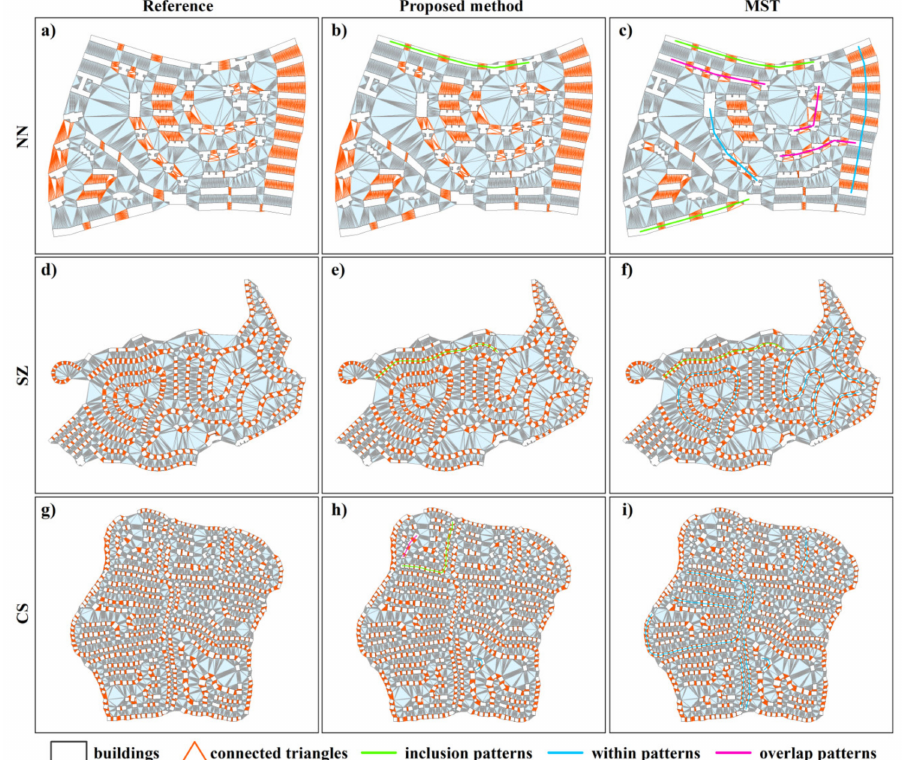
Figure 8. Linear pattern recognition results are shown for ( a )–( c ) three methods in NN dataset; ( d )–( f ) three methods in SZ dataset; ( g )–( i ) three methods in CS dataset. Buildings connected with orange triangles are recognized as linear building patterns. Misrecognized patterns are marked with di ff erently colored